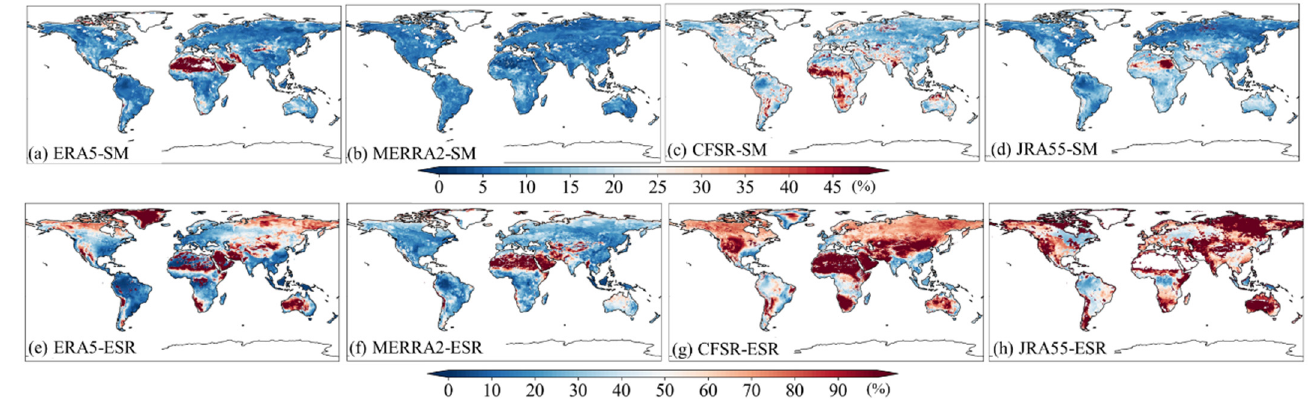
Figure 10. The relative uncertainties for the RZSM and ESR in ERA5, MERRA2, CFSR, and JRA55.